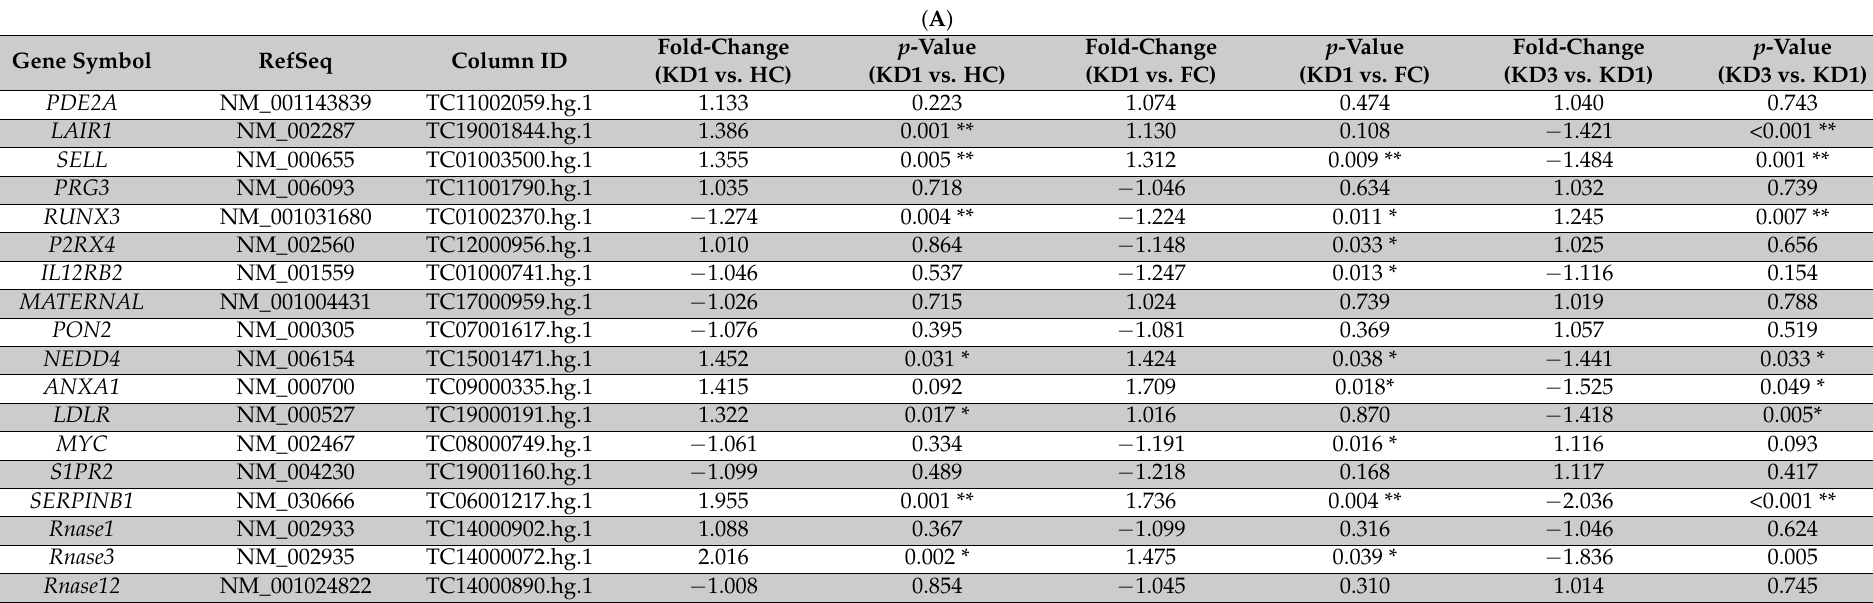
Table 2. ( A ) Molecular biomarker of lung-resident (Table 2A) and inflammatory (Table 2B) eosinophils for Kawasaki disease by transcripts expressions; ( B ) Transcript expressions of inflammatory eosinophils between Kawasaki disease patients and control